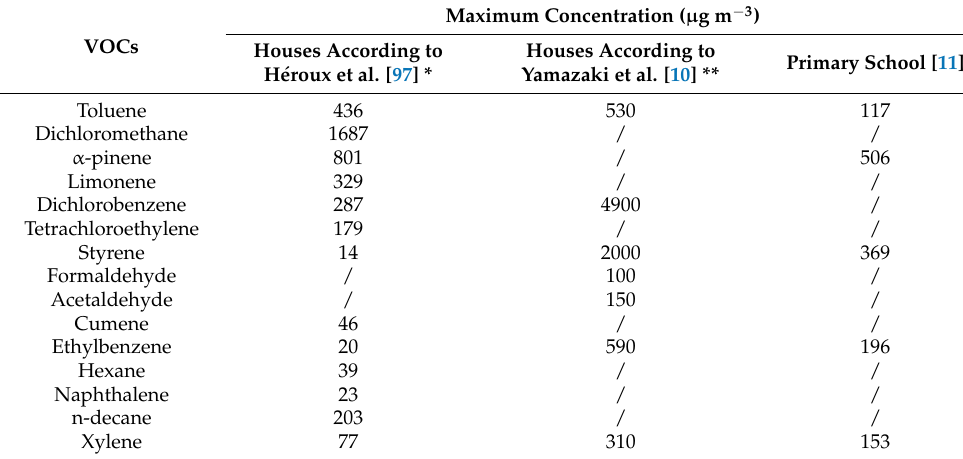
Table 2. Some of the most abundant VOCs normally found in indoor environments such as houses and